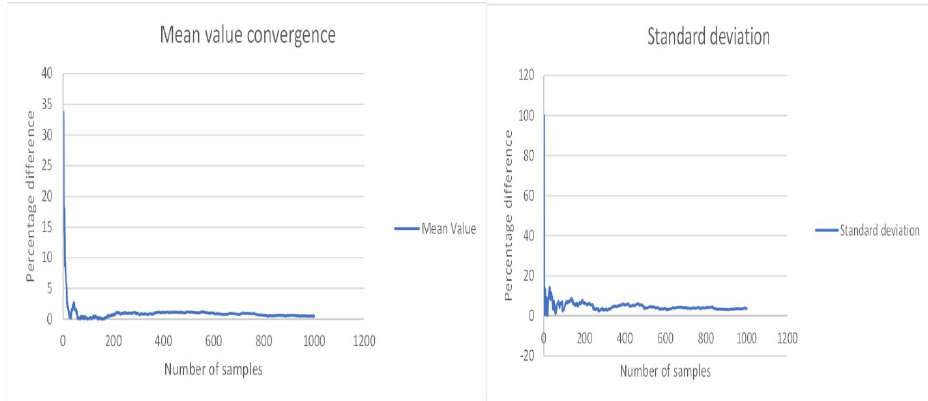
Figure 5. Convergence of the mean value and the standard deviation of a randomly selected Monte Carlo simulation for the output failure load. The reference value of the percentage difference is the statistical moment in 100